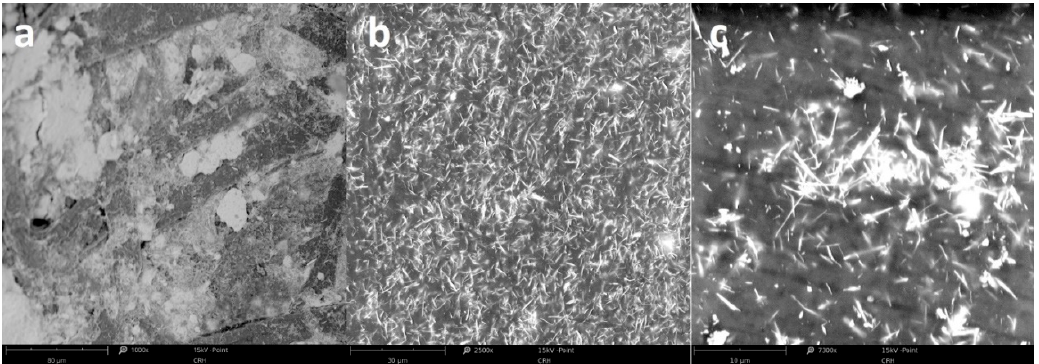
Figure 3. SEM micrographs of CSNC ( a ) and ESNC with 20% ( b ) and 40% ( c ) weight concentration of SbSI nanowires.